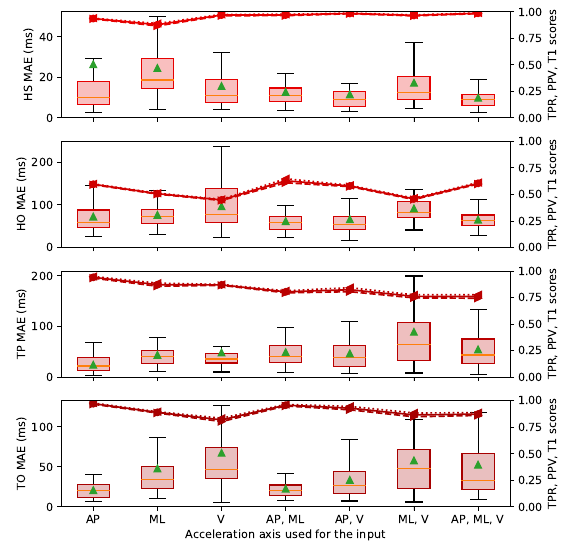
Figure 12. Same as Figure 10 for the UDS database. The ESN for GED on subset UDS all with foot IMU